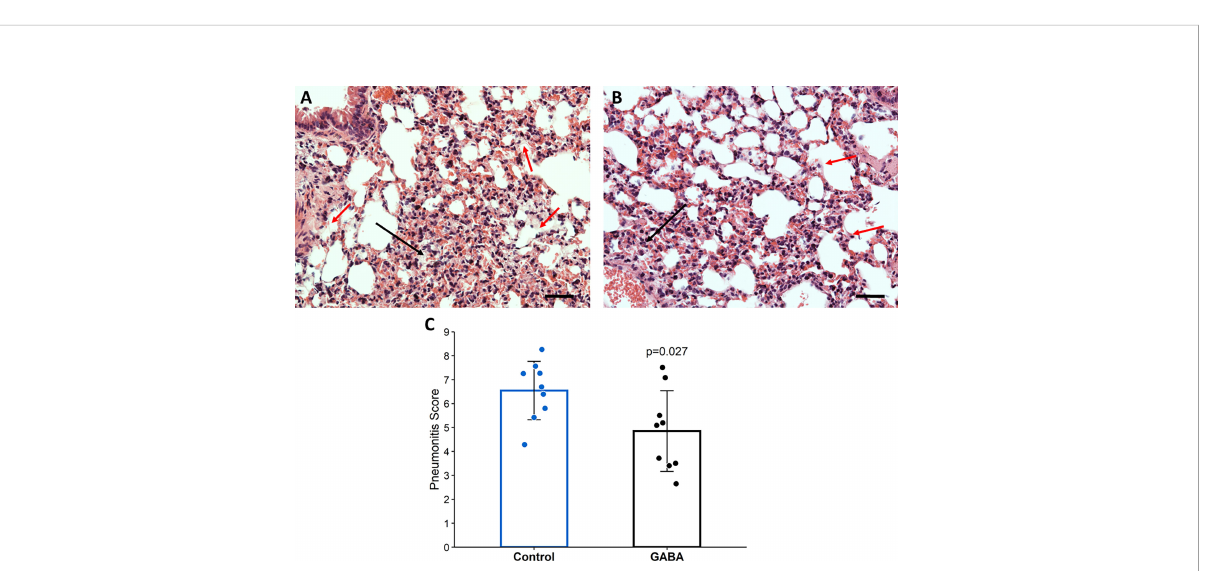
FIGURE 5 GABA treatment initiated 2-days post-infection reduces pneumonitis in SARS-CoV-2-infected mice. At the time of euthanasia, the lungs of mice studied in Figure 4 were removed and processed for histological examination as described in Methods. Representative images of H&E-stained lung sections (magni fi cation × 200) from (A) untreated mice and (B) GABA-treated mice. Red arrows point to hyaline-like membranes and black arrows indicate local consolidation. The scale bar is 50 µm; (C) Quantitative analysis of the degrees of pneumonitis in the lungs. Data are expressed as the mean pneumonitis score ± SD of each group. The data were analyzed by Student t-test. N=9 mice per group.